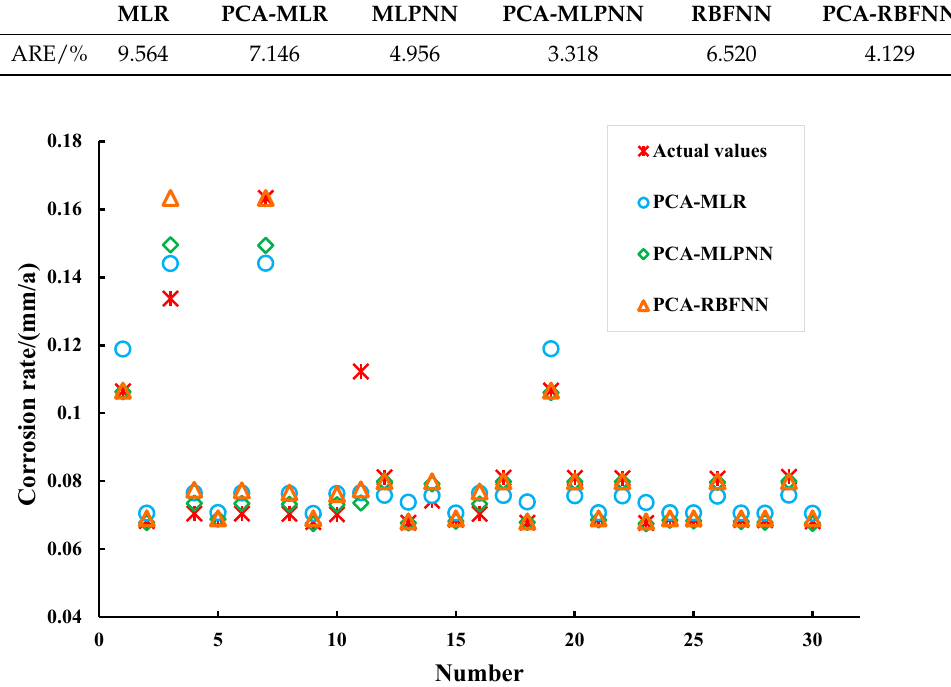
Figure 5. Comparison of model prediction results.